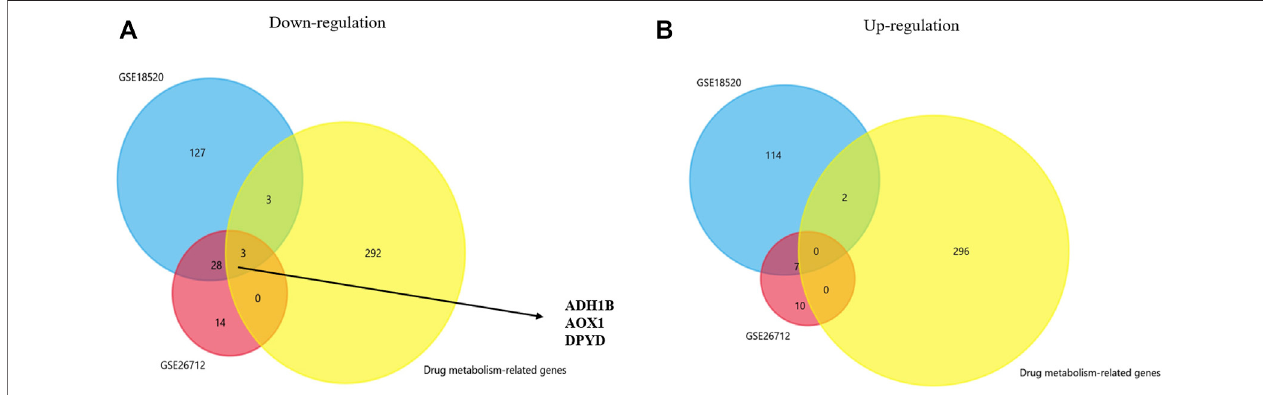
FIGURE 1 | Venn plot for identifying co-DEGs. (A,B) Two GEO datasets and the drug metabolism-related gene dataset were used to identify the upregulated and downregulated co-DEGs, respectively.